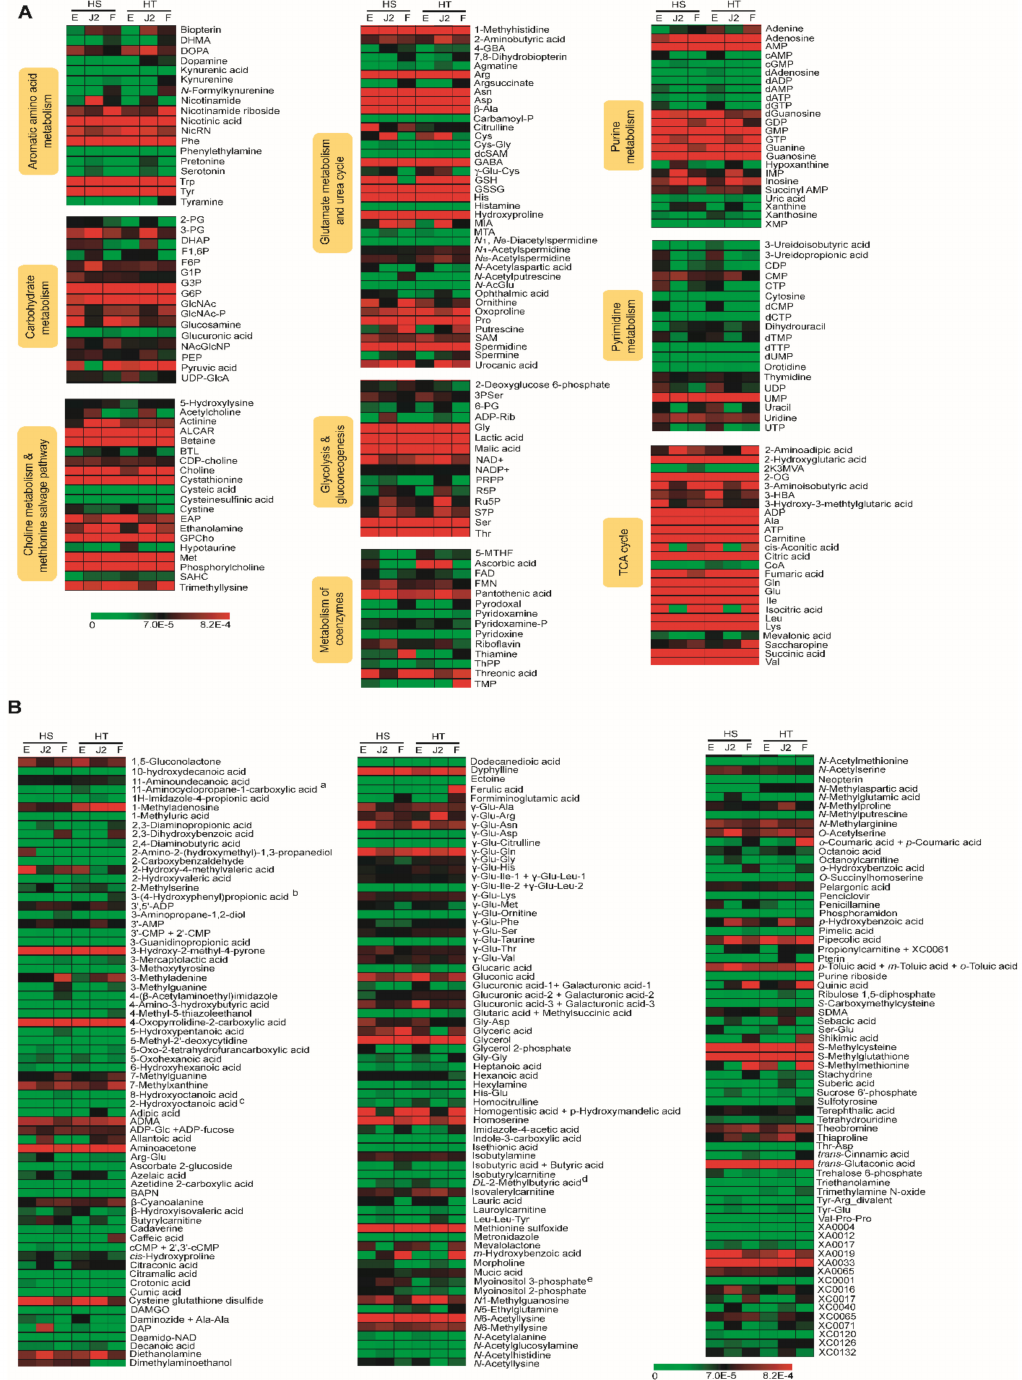
Figure 4. Heat map of changes in metabolite levels at the egg, J2, and female stages of H. schachtii (HS) and H. trifolii